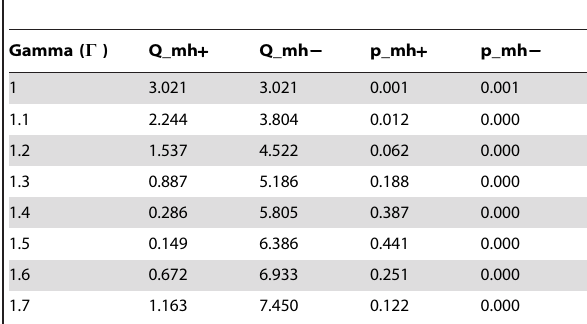
Table 6 . A sensitivity analysis using Mantel-Haenszel (1959) bounds for variable child